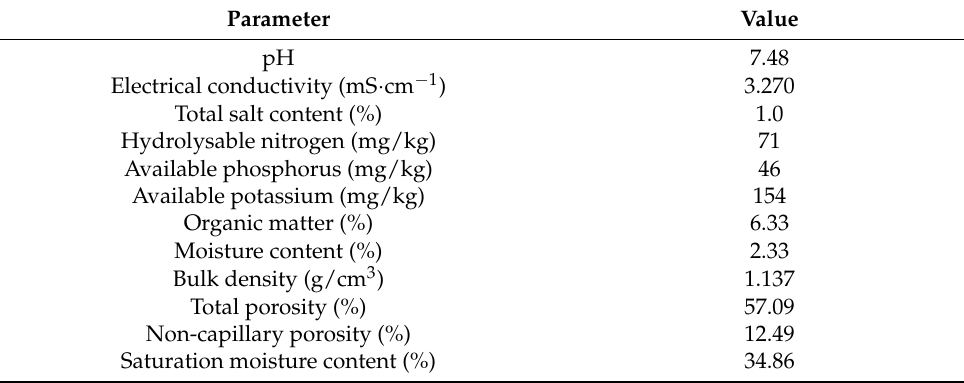
Table 1. Physical and chemical properties of SL in this study.